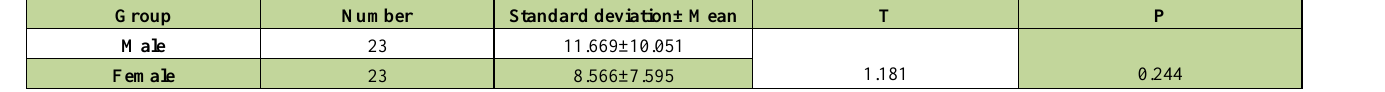
Table 5. Comparison of mean difference of index plaque of first period between the two genders.